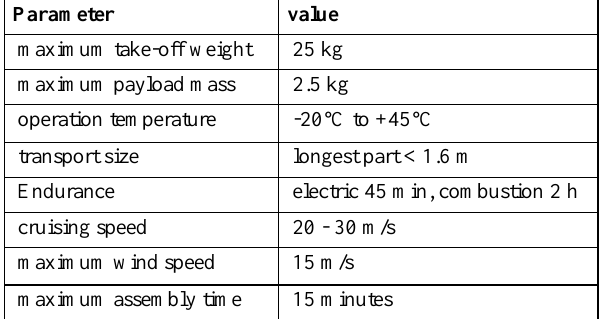
Table 2. Design Restrictions of the Carolo P 360 (Scholtz, 2009)